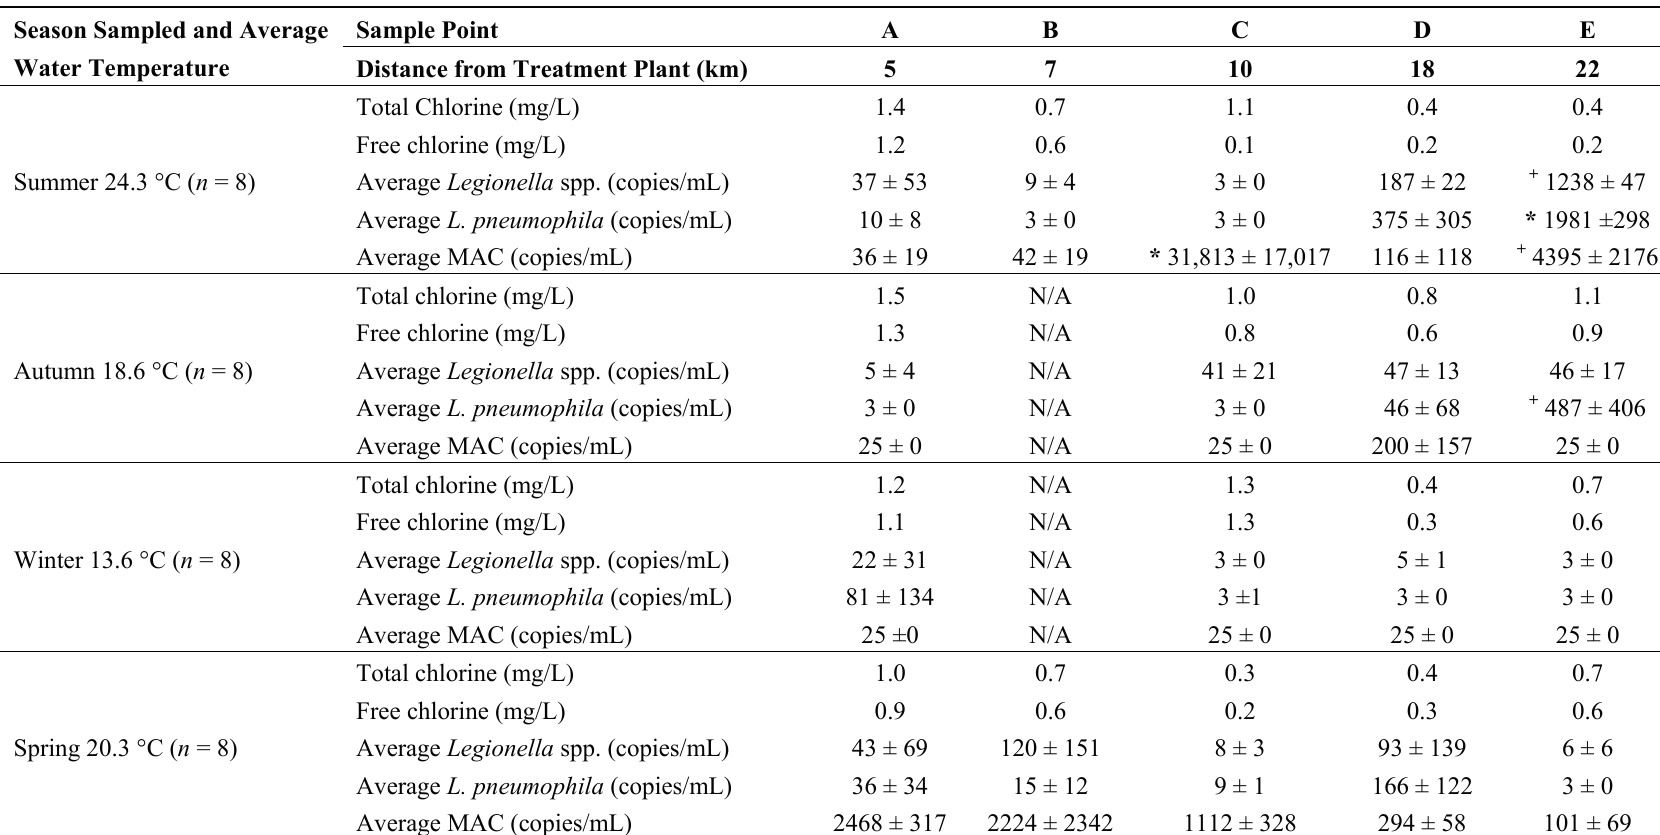
Table 1. Average concentration of Legionella spp. L. pneumophila and MAC (mean ± standard deviation copies/mL) measured at each sampling point of Distribution system 1 (DS1) using qPCR. Total and free chlorine (mg/L) measured when samples were collected is also shown as well as the average water temperature for the month during which the sample was taken. The sampling points where a significant increase ( p < 0.05) in the concentration of an organism compared to the concentration measured at sample point A within the same sampling period are also highlighted ( *